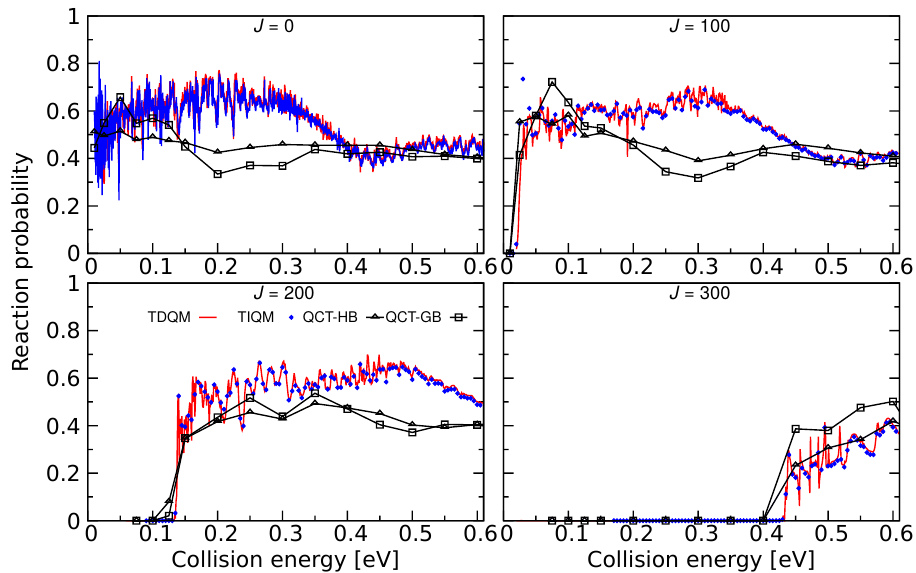
Figure 17. Total reaction probabilities as a function of collision energies for the Ar + ArH + ( v = 0, j = 0 ) → ArH + + Ar for J = 0, 100, 200, and 300 computed following TIQM (blue solid lines and symbols), TDQM (red solid lines), and QCT (QCT-HB: green lines+symbols, QCT-GB: black lines+symbols) methodologies. Data taken from Ref. [71].